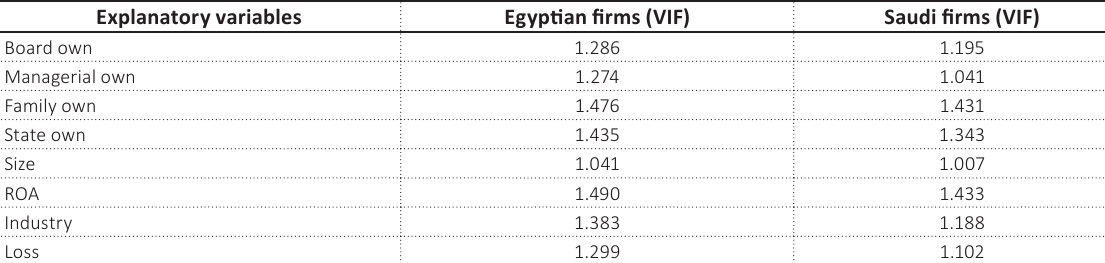
Table 5. Variance inflation